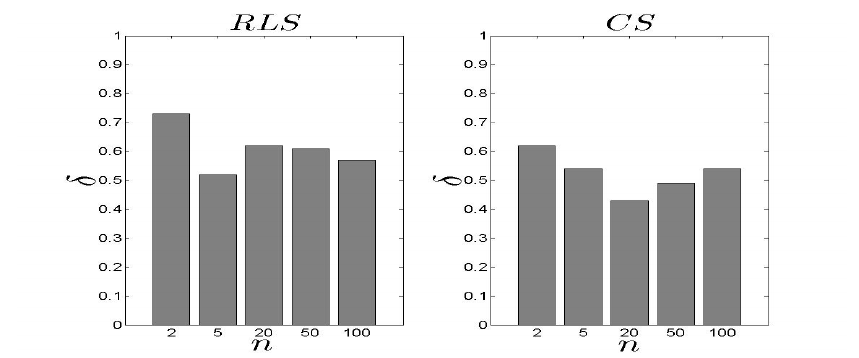
Figure 10. RLS and CS results for the φ metric.